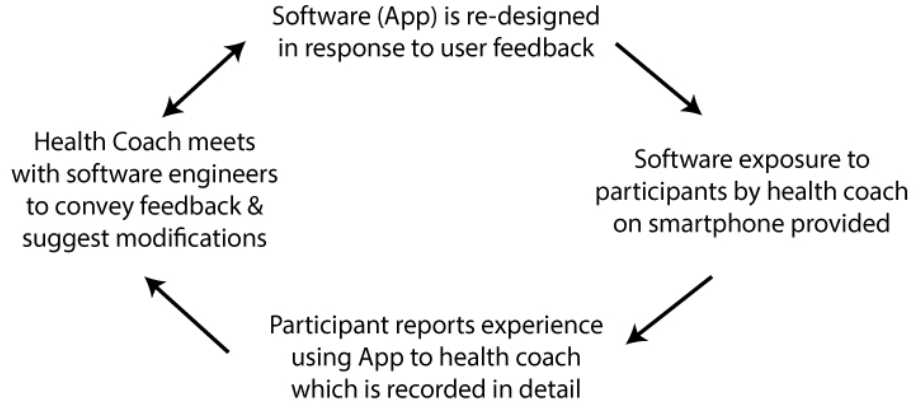
Figure 1. Software improvement cycle. Feedback loop conveys user experience and smartphone software redesign.